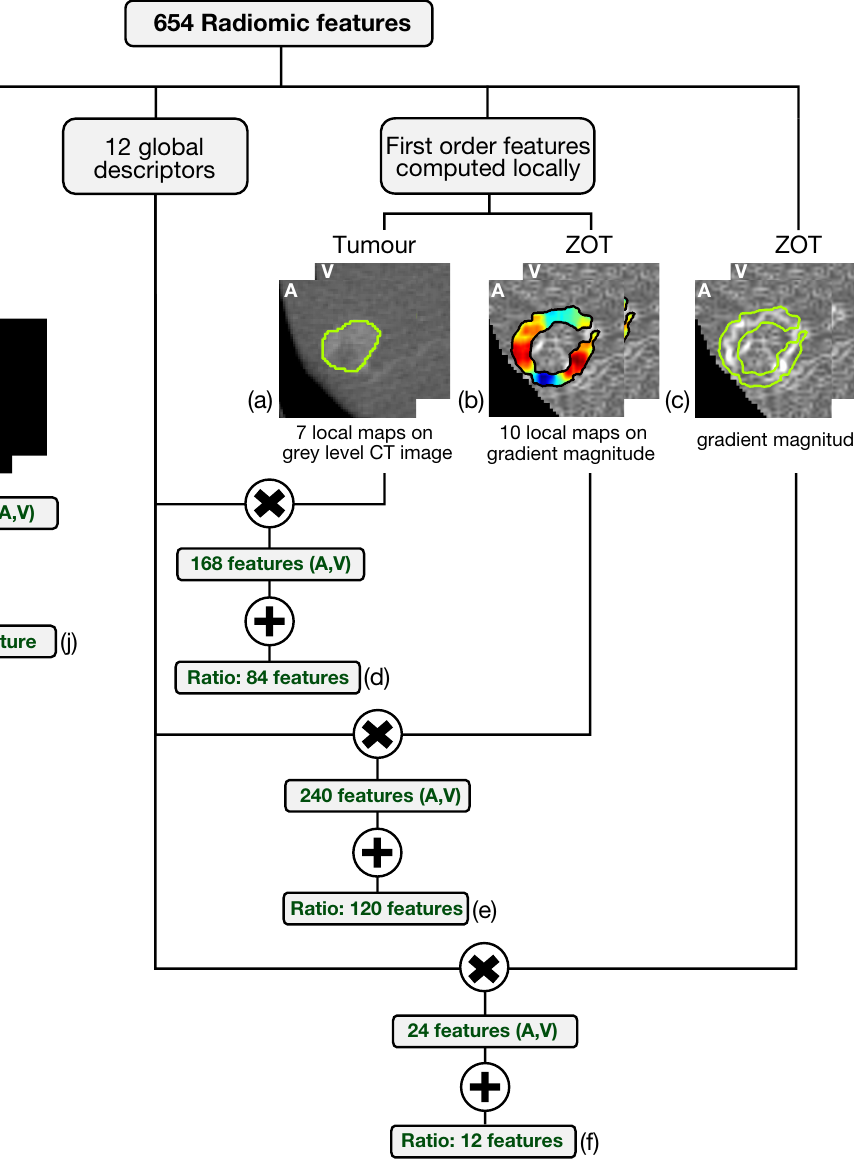
Figure 4. The scheme summarizes the feature generation process. The six-hundred fifty-four radiomic features include 648 features achieved through the computation of 12 global descriptors on different local maps of first order features referred to tumour on grey level CT images (a) and ZOT (b,c) on gradient magnitude images, yielding 84 (d), 120 (e), and 12 (f) features, respectively. In addition, 6 features measure, in pixels, the ROI volume of tumour (g) and ZOT (h) in both arterial (A) and venous (V) phases as well as their ratio